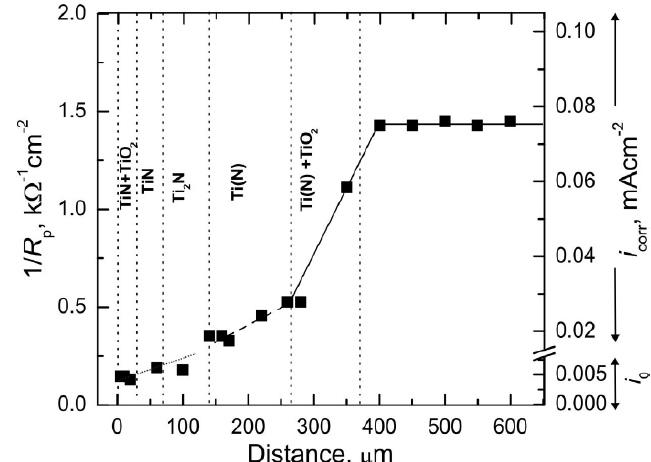
Figure 4. Depth profile of reciprocal of polarisation resistance and corrosion current density (for depths up to 140 mm – exchange current density of H +